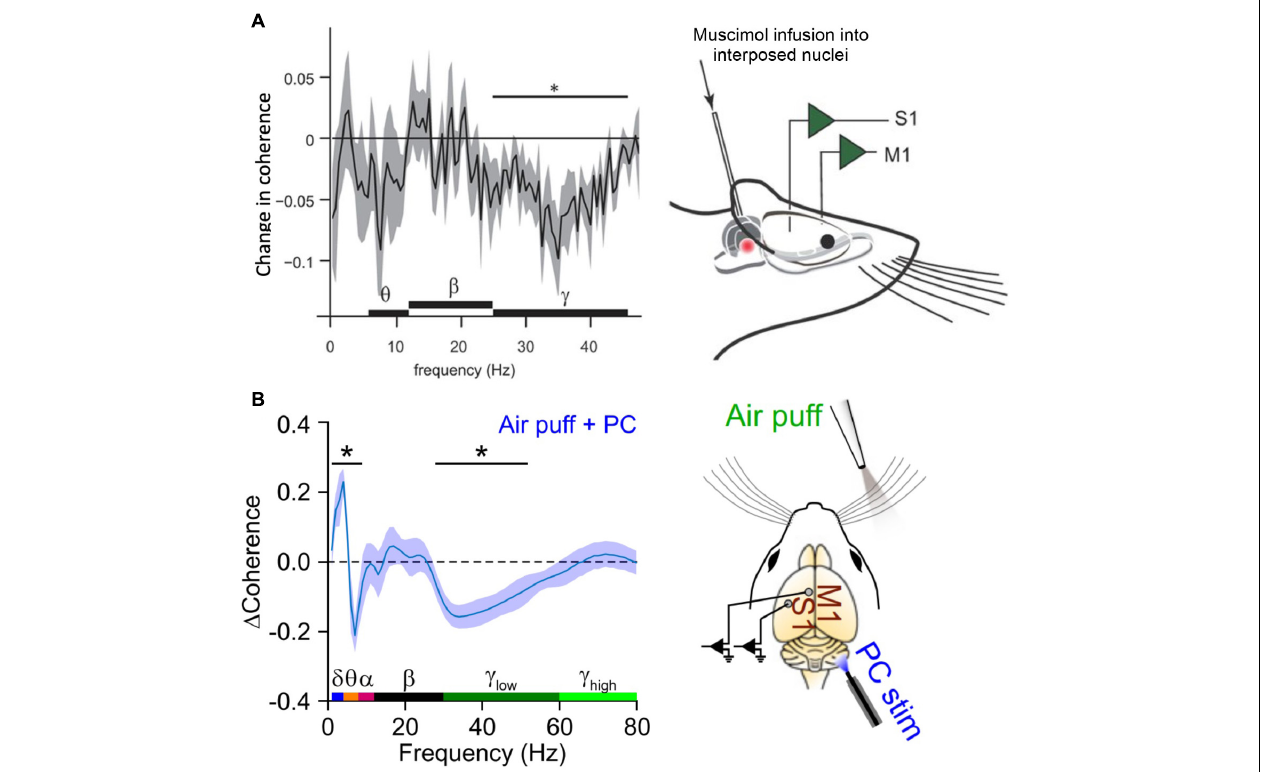
FIGURE 2 | Inactivation of cerebellar output reduces gamma coherence between S1 and M1. (A) In an experiment that involved simultaneous measurements of LFPs in S1 and M1 of awake, head fixed rats, Popa et al. (2013) demonstrated that pharmacological inactivation of the interposed nuclei selectively reduced gamma coherence between S1 and M1. The plot on the left shows a change in coherence relative to the control condition in which the interposed was kept intact. The experimental approach is illustrated on the right (from: Popa et al., 2013). (B) A similar, recent experiment showing that optogenetic inhibition of cerebellar output ( via Purkinje cell excitation) significantly reduced the coherence of gamma responses evoked by whisker stimulation. The plot on the left shows estimated effect of Purkinje cell stimulation on coherence between deep layer S1 and superficial layer M1. Theta-range S1–M1 coherence was enhanced with Purkinje cell stimulation (from: Lindeman et al., 2021). *These frequencies were statistically significant ( p <